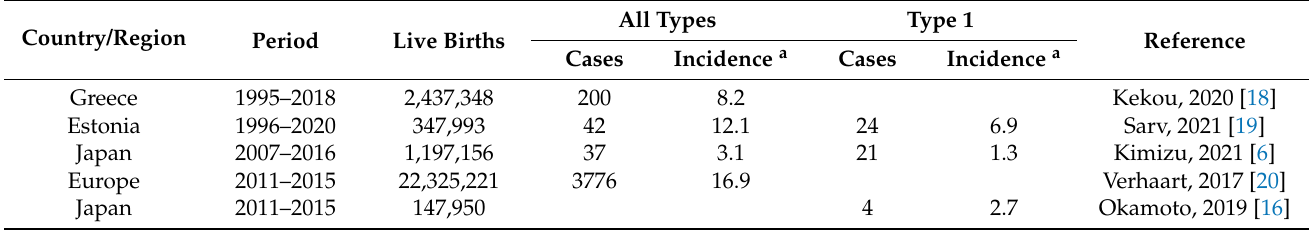
Table 3. Spinal muscular atrophy incidence reported in previous